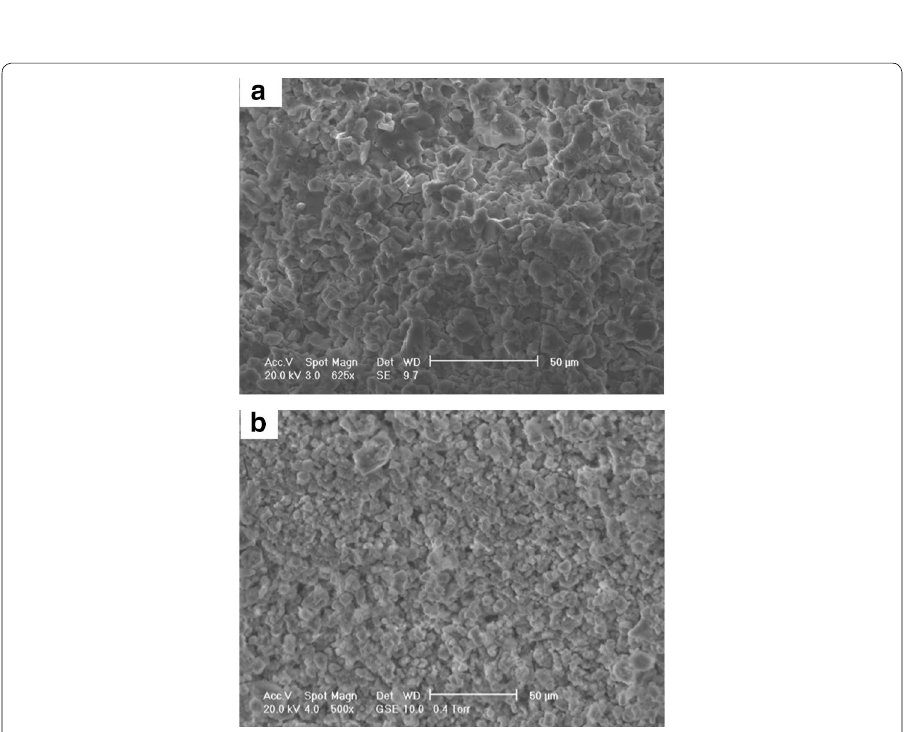
Fig. 15 Microstructure of the samples; a CDV sample and b HDV